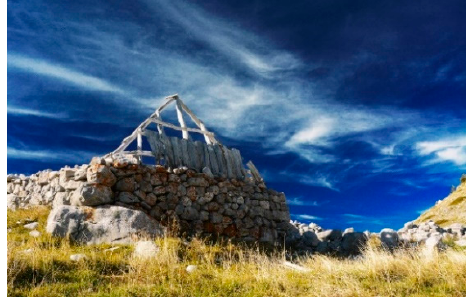
Figure 24. Roof construction of the glada with rafters, Momonjevo, photo: I. Lakovi ć .